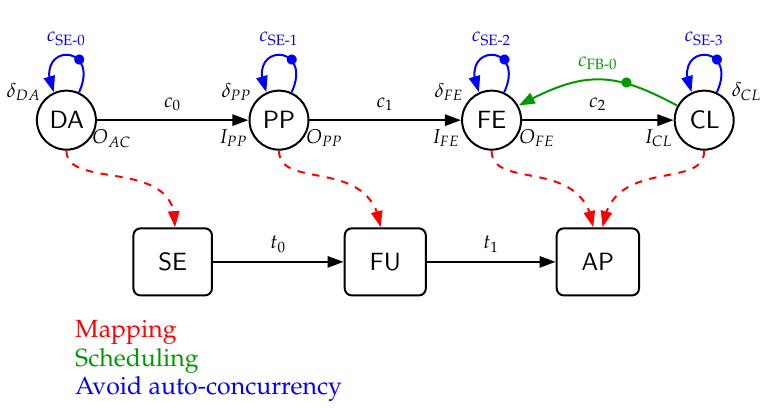
Figure 8. Two different mappings, calculating the feature extraction on ( a ) the FuserCore or ( b ) the smartphone of our hardware setup.